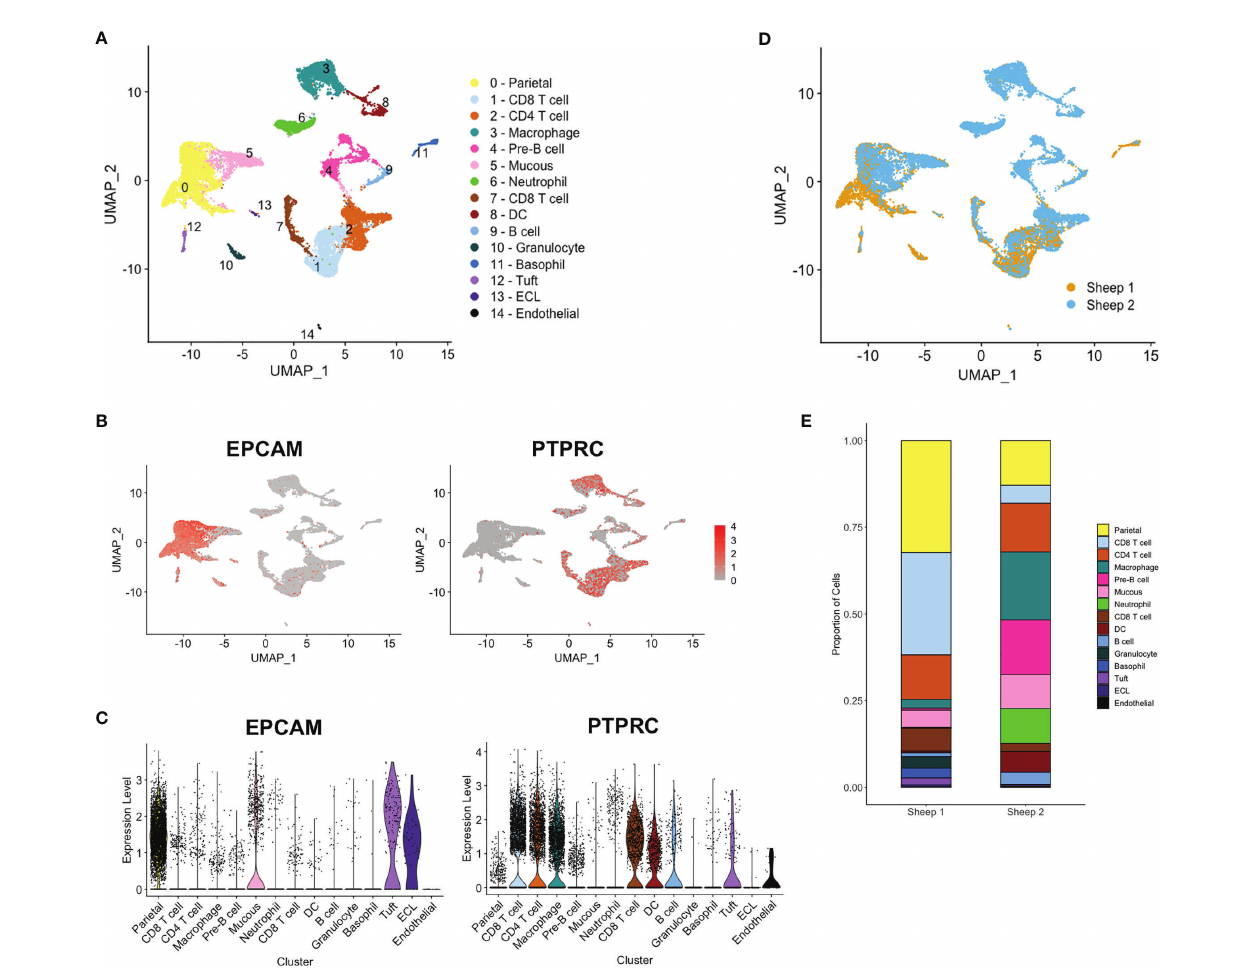
FIGURE 3 | Single cell RNA sequencing (scRNA-seq) identi fi es distinct ovine abomasal cell clusters. (A) UMAP (Uniform manifold approximation and projection) plot of cell clusters identi fi ed from integrated data from sheep 1 and 2 following mapping to bovine genome. DC - dendritic cells, ECL - enterochromaf fi n-like cells. Cell clusters were putatively identi fi ed by expression of marker genes (see Supplementary Table 6 ). Expression of epithelial cell marker EPCAM and immune marker PTPRC ( CD45 ) across all clusters, shown by (B) UMAP and (C) violin plots. (D) UMAP plot of sheep 1 and 2 overlapped. (E) Relative proportion of cells within each cluster for sheep samples 1 and